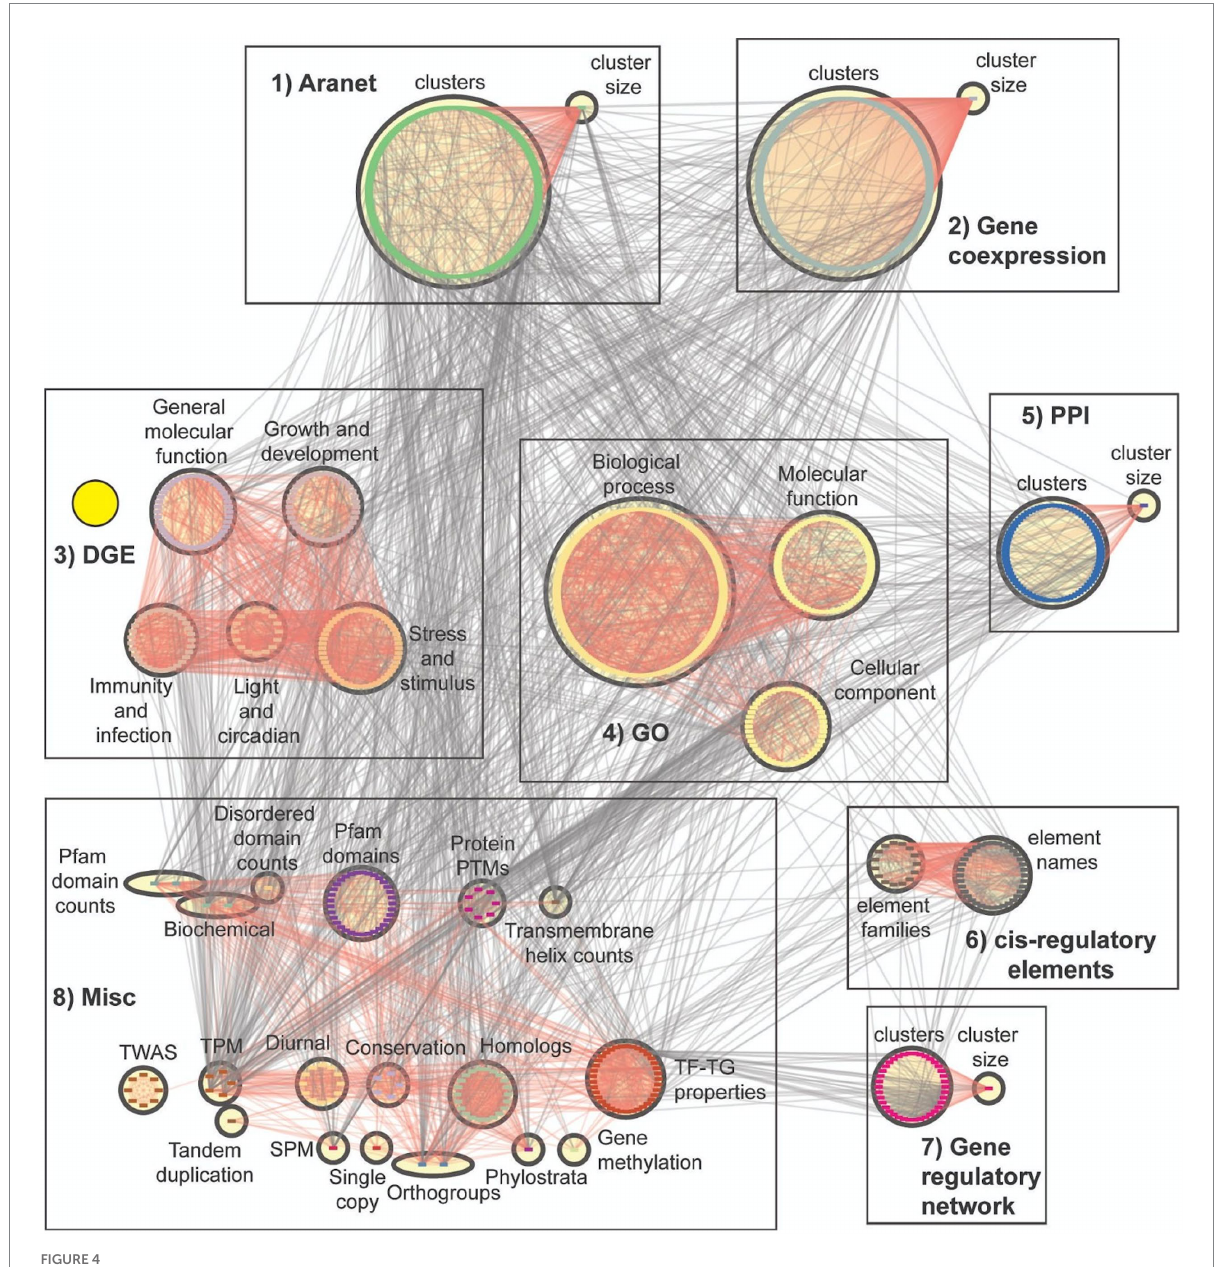
FIGURE 4 Feature importance network. Nodes represent features while edges connect features that have putative biological links. The features are divided into eight major groups (Table 2). Red edges show relationships within groups belonging to the same box. These groups are divided into eight boxes, and the first seven boxes represent clusters of feature categories. The boxes are 1 (Aranet features: cluster IDs and size), 2 (gene coexpression features: cluster IDs and size), 3 (DGE features: subdivided into five categories), 4 (GO terms: subdivided into three categories), 5 (PPI features: cluster IDs and size), 6 (cis-regulatory elements), 7 (gene regulatory features: cluster IDs and size), and 8 (a miscellaneous group which contains all other feature categories). Yellow circle highlights DGE features, showing how many of them are linked to each other, while also having links to other